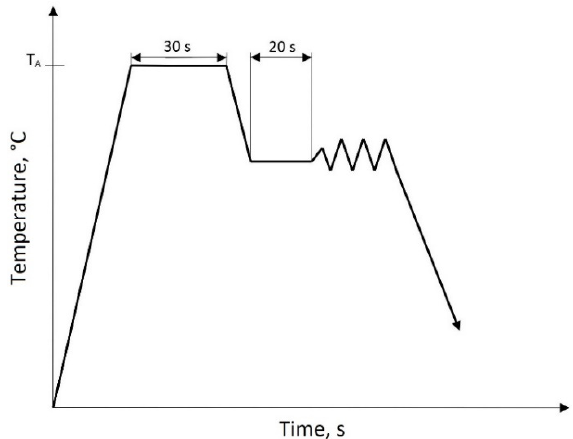
Figure 1. Diagram of continuous compression of samples.